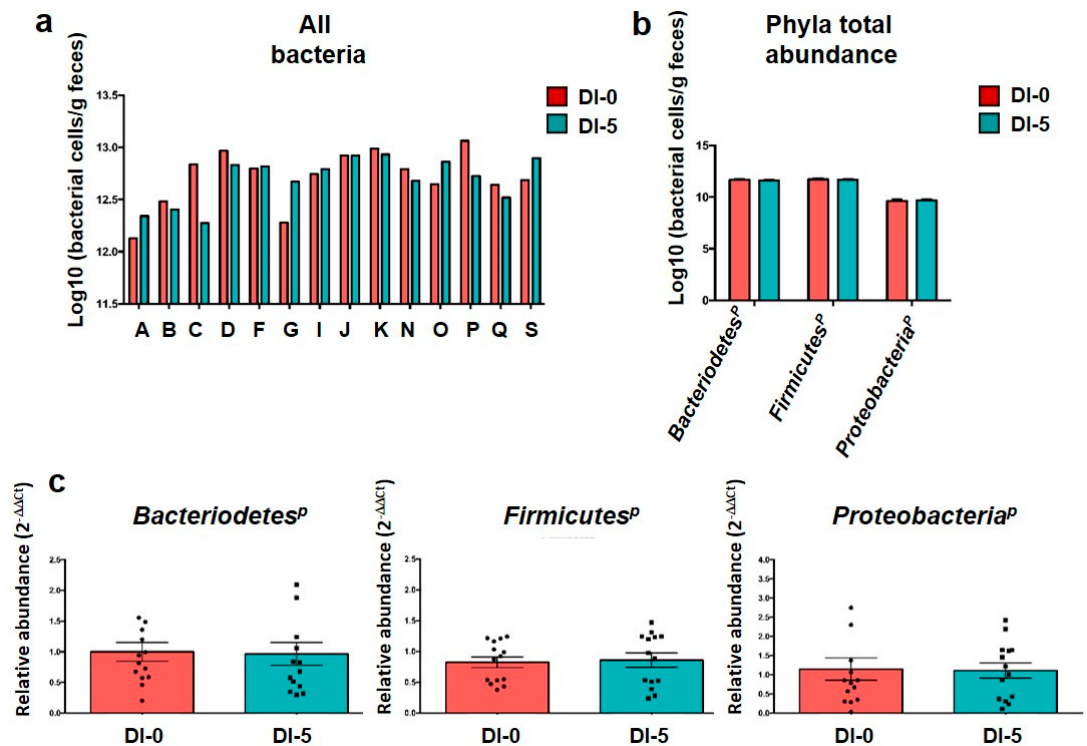
Figure 2. Gut microbiota composition analysis by qPCR. ( a ) “All bacteria” abundance evaluated by qPCR before (DI-0) and after 5 days of dry immersion (DI-5) in healthy men ( n = 14). ( b ) Mean abundance of the three main gut microbiota phyla quantified by qPCR at DI-0 and DI-5 in healthy men ( n = 14). ( c ) Mean abundance of each phylum by qPCR normalized to the “all bacteria” abundance at DI-0 and DI-5 in healthy men ( n = 14). No significant difference between DI-0 and DI-5 for all panels (paired t-test); p = Phylum. Data are mean ± SEM.